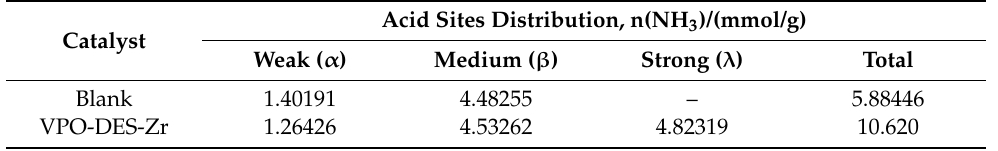
Figure 14. TG-DTA analysis of the unpromoted precursor (Blank-PVPO) ( a ), and promoted precursors prepared from monometallic ( b ), bimetallic ( c ), and trimetallic ( d ) DES. Table 2. NH 3 -TPD results describing the acidic sites and their acidic strength for activated Ce-DES- VPO catalysts under different activation